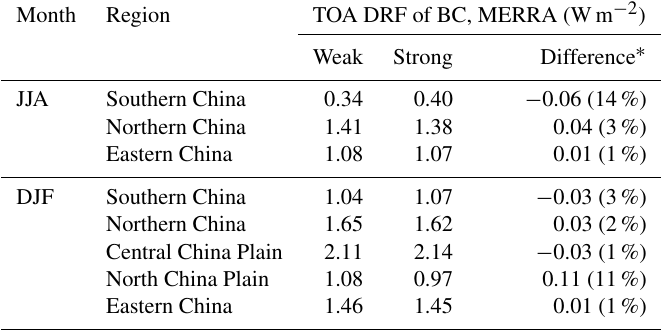
Table 4. Simulated JJA (DJF) mean all-sky direct radiative forcing (DRF) of BC (Wm − 2 ) at the top of the atmosphere (TOA) in the 5 weakest and 5 strongest EASM (EAWM) years during 1986–2006. Results are from simulation VMET averaged over eastern China (110–125 ◦ E, 20–45 ◦ N), northern China (110–125 ◦ E, 28–45 ◦ N), the North China Plain (110–125 ◦ E, 37–45 ◦ N), the Central China Plain (110–125 ◦